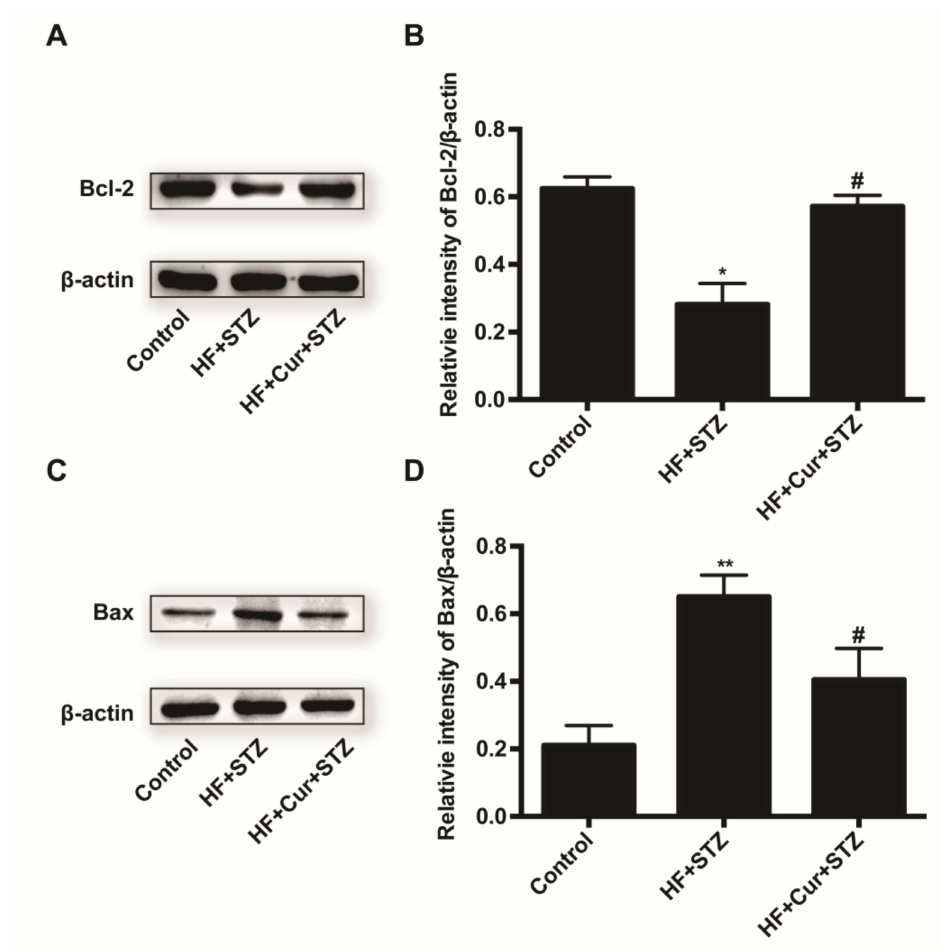
Figure 7. The e ff ect of curcumin intervention, Bcl-2, and Bax expression in rats fed a high-fat diet then treated with streptozotocin. ( A ) The expression of Bcl-2 in each group after curcumin pretreatment was verified by Western blotting. ( B ) The statistical analysis was performed for the Western blotting results depicted in Figure 7A using Image Pro Plus software. ( C ) The expression of Bax in each group after curcumin pretreatment was verified by Western blotting. ( D ) Statistical analysis was performed for the Western blotting results depicted in Figure 7C using Image Pro Plus software. The data are expressed as the mean ± SEM. * p < 0.05, ** p < 0.01, compared with the control group; # p < 0.05, compared